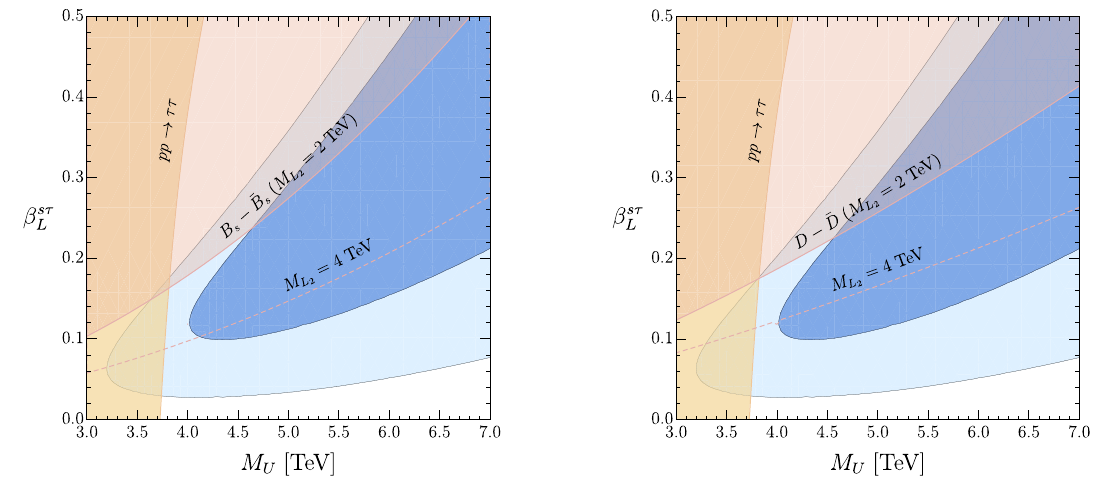
¯ B ¯ D for different benchmarks values of the vector- Figure 5 . 95% CL constraints from B and D s − s − and with g = 3 . 0. The 1 σ and 2 σ regions preferred by the low-energy fit are like lepton mass M L 2 U shown in blue and light blue, respectively. For reference, we also show the high- p ττ taken from [27] and discussed in section 2.4. In the right plot we fix s χ = 0 . 55 and s (cid:26)